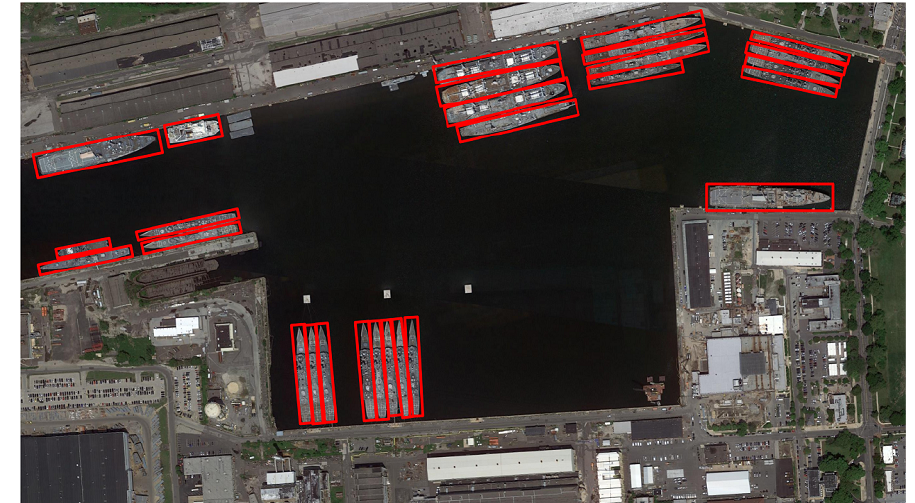
Figure 11. The detection results of one large-scale remote-sensing image (2605 ×